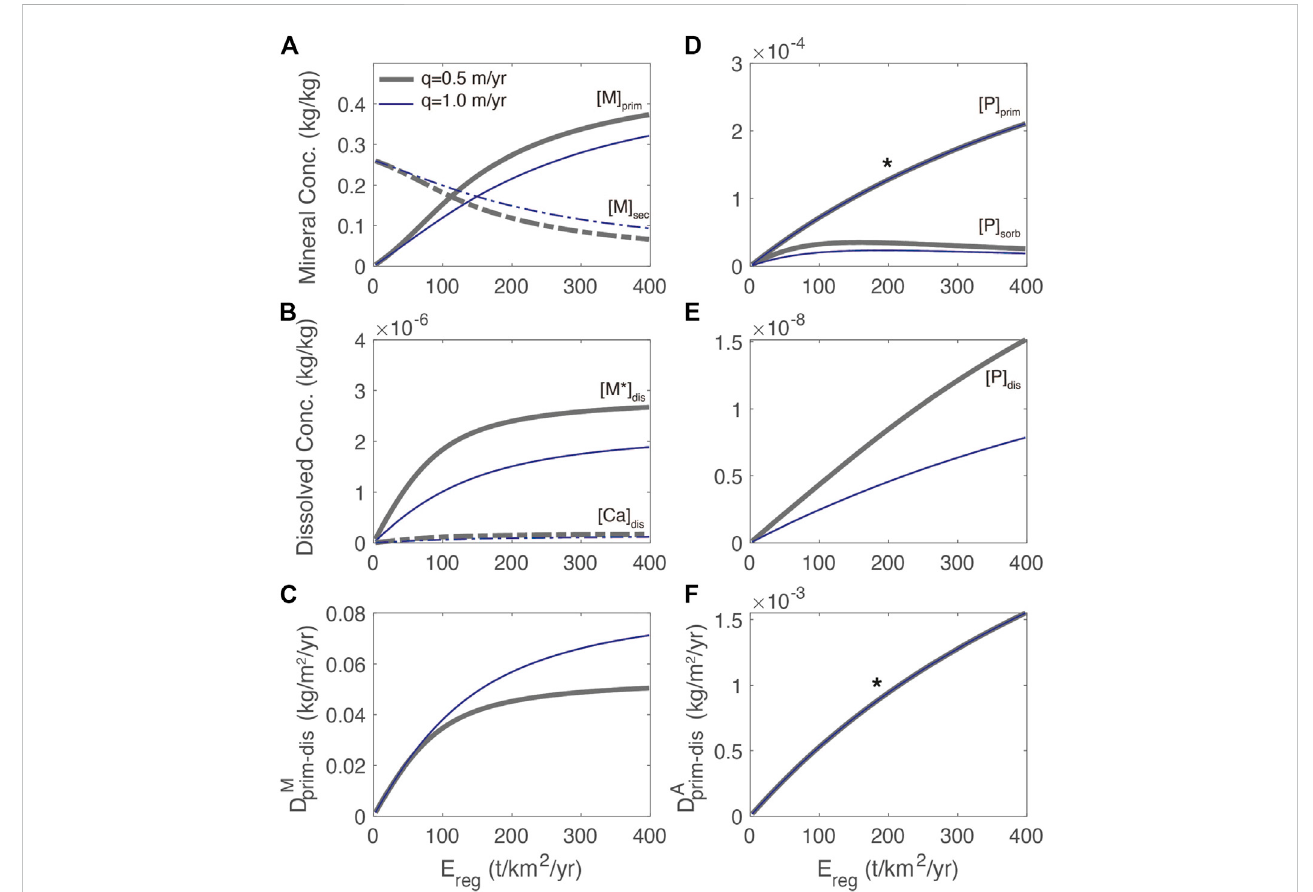
FIGURE 3 Regolith weathering model showing (A) concentrations of primary mineral [M] prim , and secondary mineral [M] sec as a function of total erosion rate, E reg , for two different fl ow rates. Reference model of q = .5 m/yr shown in green is approximately global runoff, q = 1 m/yr is more typical of tropical systems; (B) concentration of dissolved primary mineral and Ca dissolved thereof (C) dissolution rates of primary mineral; (D) accessory primary mineral [A] prim , and sorbed P [P] sorb (E) dissolved P [P] dis ; and (F) dissolution rate of [A] prim . Note that in (D) and (F) , the * indicates two fl ow rates have identical primary mineral and dissolution rate pro fi les,